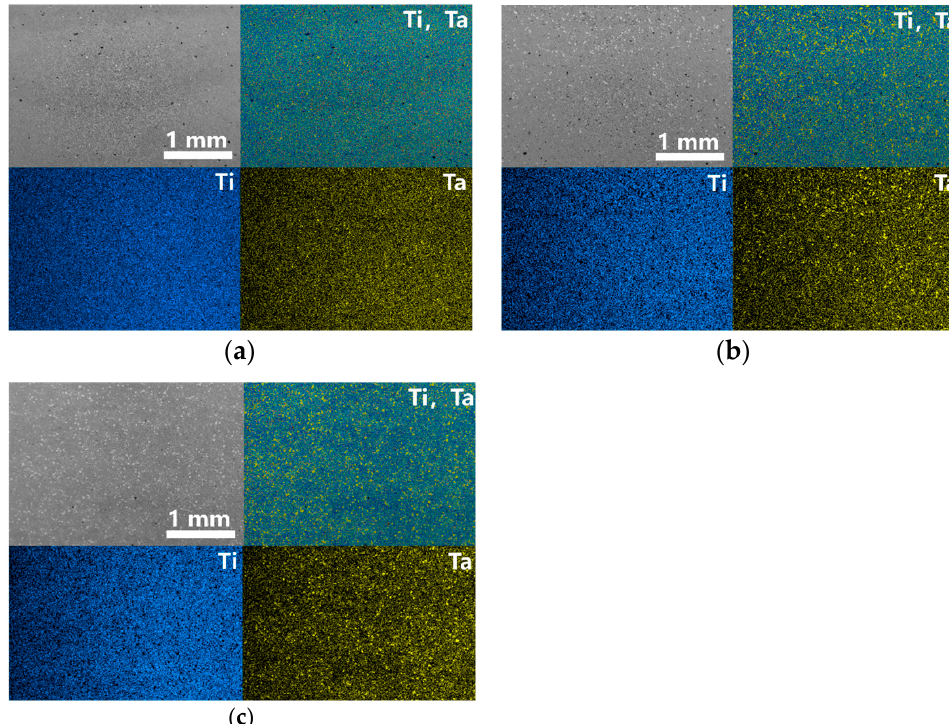
Figure 6. EDS surface scan results of LPBF Ti ‐ Ta at different parameters: ( a ) sample S1 (v = 120 mm/s, E = 694 J/mm 3 ), ( b ) sample S2 (v = 220 mm/s, E = 381 J/mm 3 ), ( c ) sample S3 (v = 1100 mm/s, E = 76 J/mm 3 ).